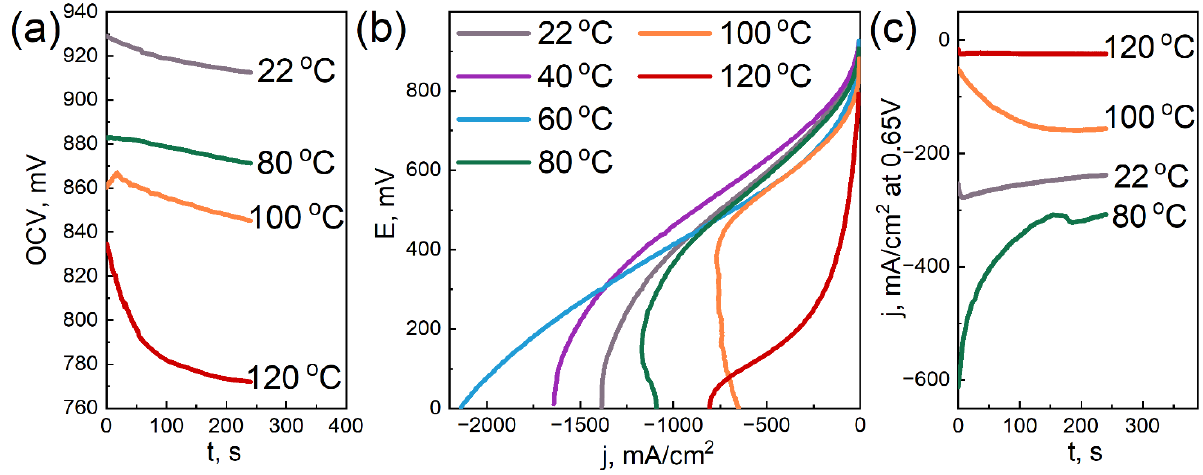
Figure 8. Electrochemical characteristics of the MEA with the Aquivion ® -type membrane (EW = 897 g-eq/mol) with a 2.6 wt.% DND Z+ at different temperatures: OCV vs. time ( a ); voltammograms ( b ); and current density in the potentiostatic mode at a voltage of 0.65 V vs. time ( c